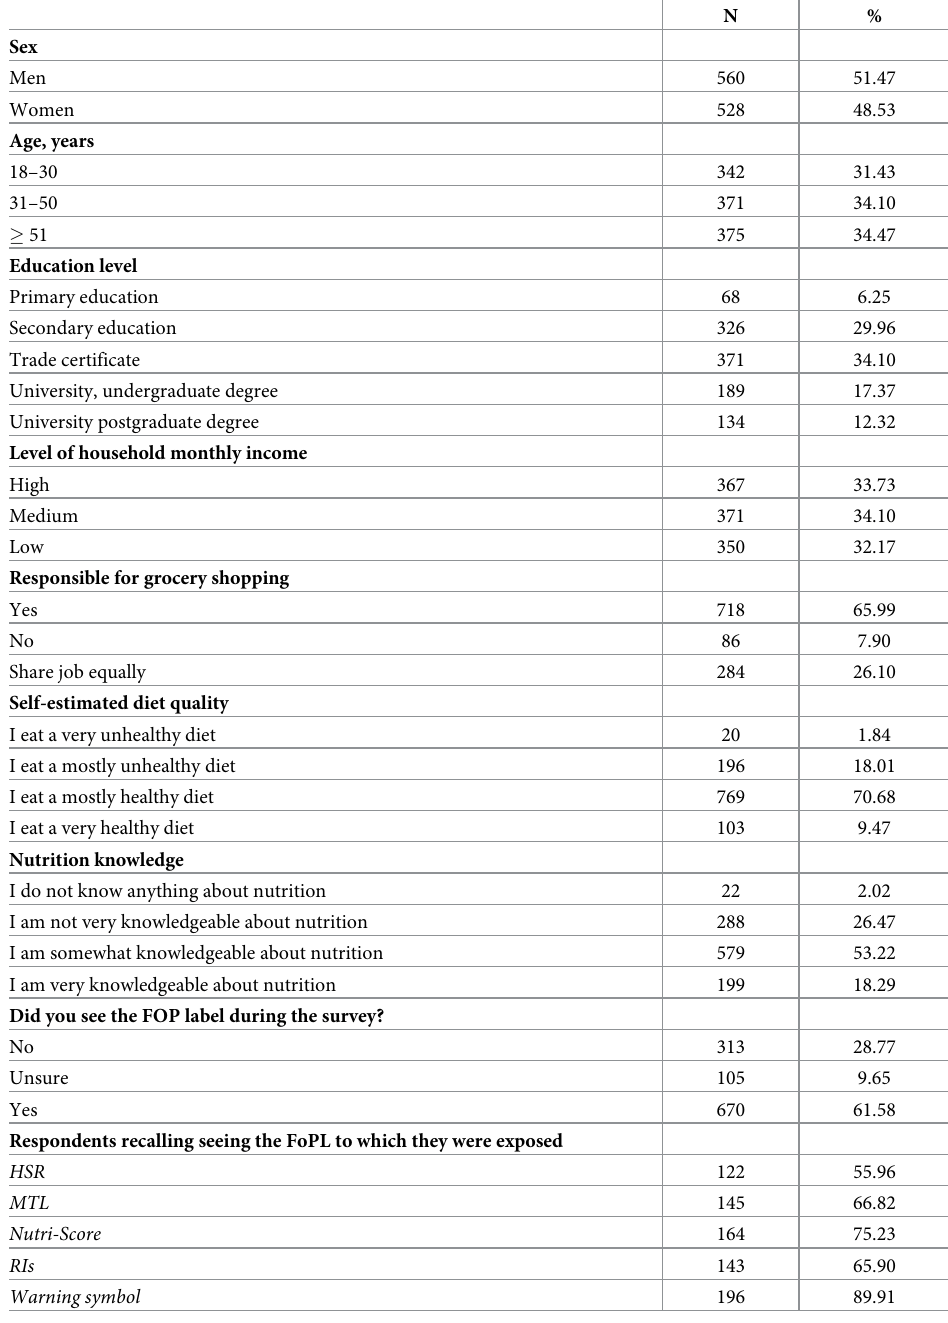
Table 1. Individual characteristics of the study sample (N =